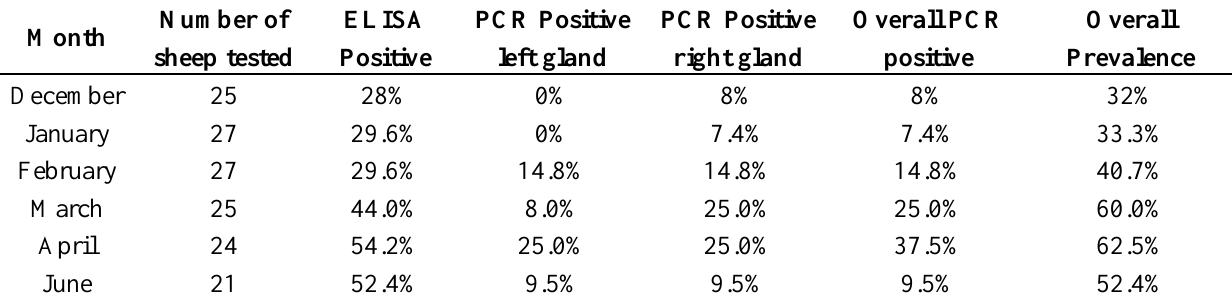
Table 1. Monthly evolution of the prevalence of sheep positive to Small Ruminant Lentivirus (SRLV) by enzyme-linked immunosorbent assay (ELISA) and Polymerase Chain Reaction (PCR).